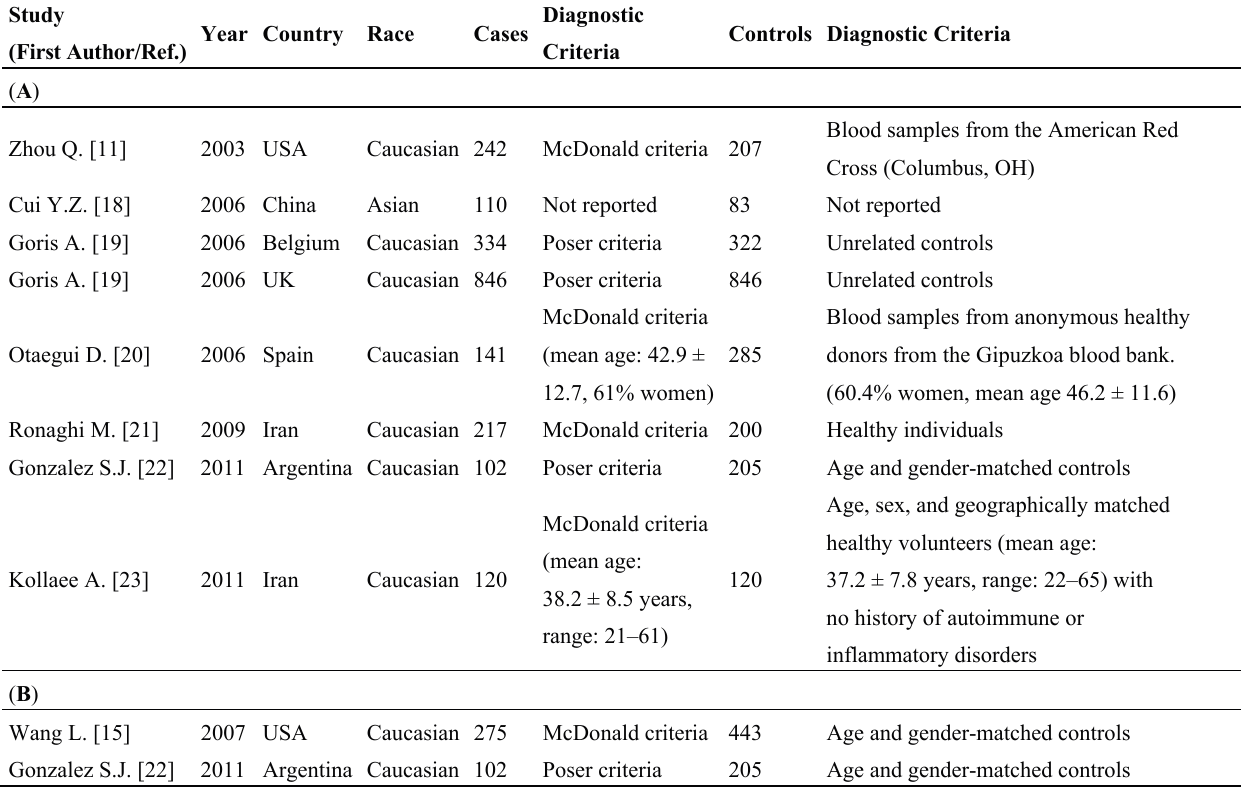
Table 2. ( A ) Characteristics of studies included in the meta-analysis for the association of the 226 C>T polymorphism of the CD24 gene with MS; ( B ) Characteristics of studies included in the meta-analysis for the association of the 1527–1528 TG>del, 1056 A>G and 1626 A>G polymorphisms of the CD24 gene with